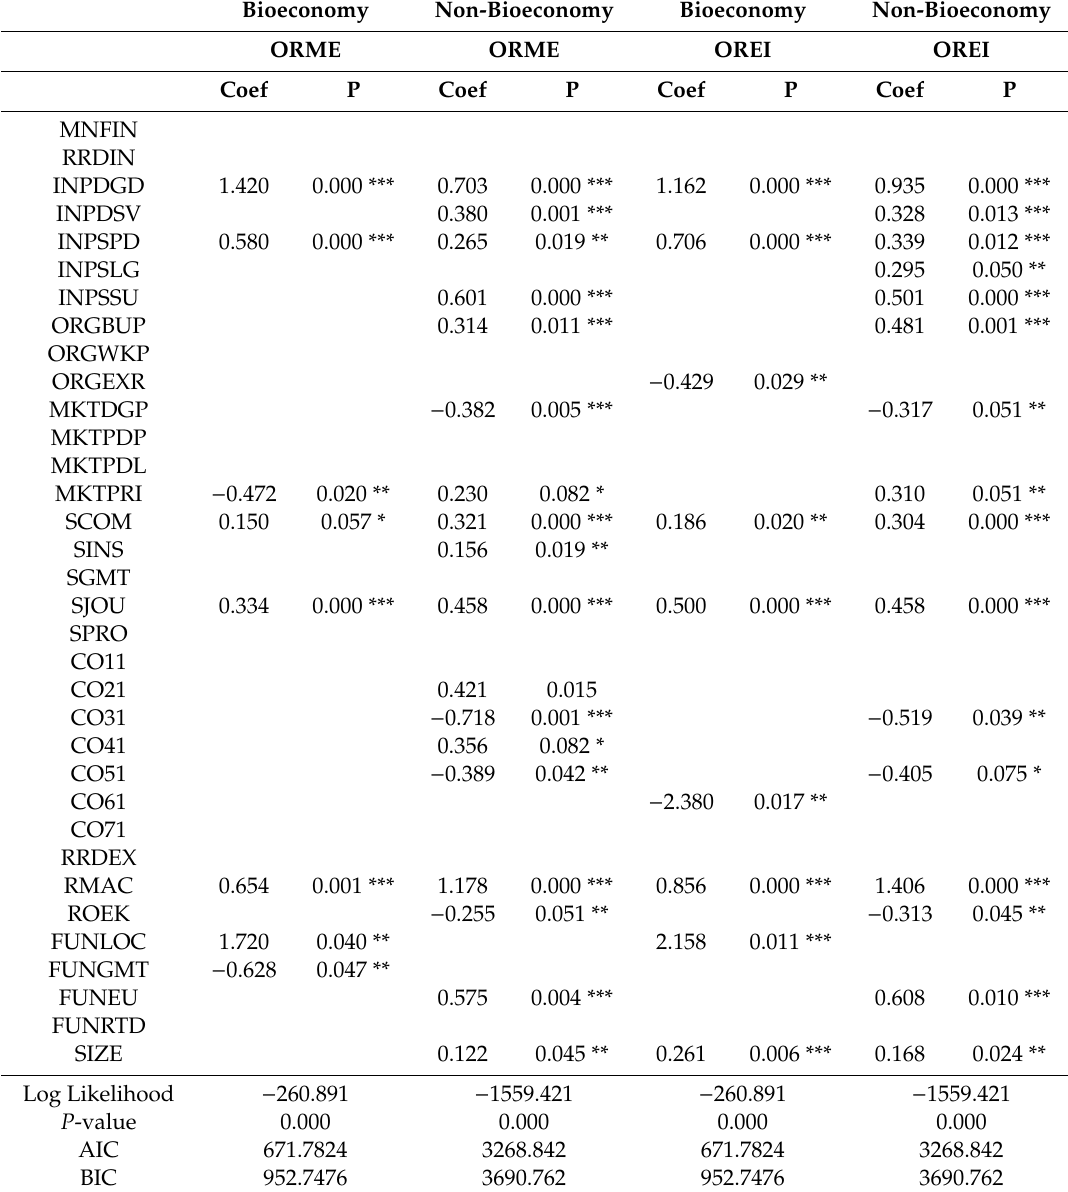
Table A3. Estimation results of multivariate tobit model